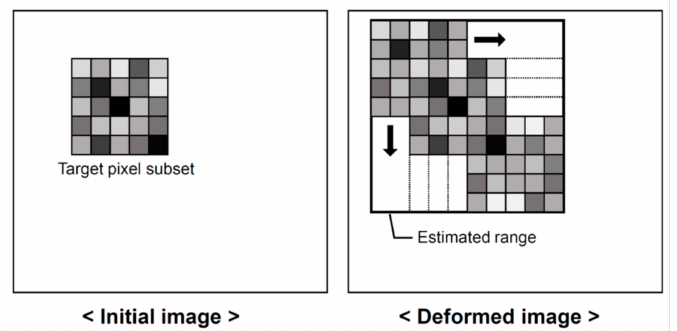
Figure 4. Cross-correlation with the Particle image velocimetry (PIV) technique.